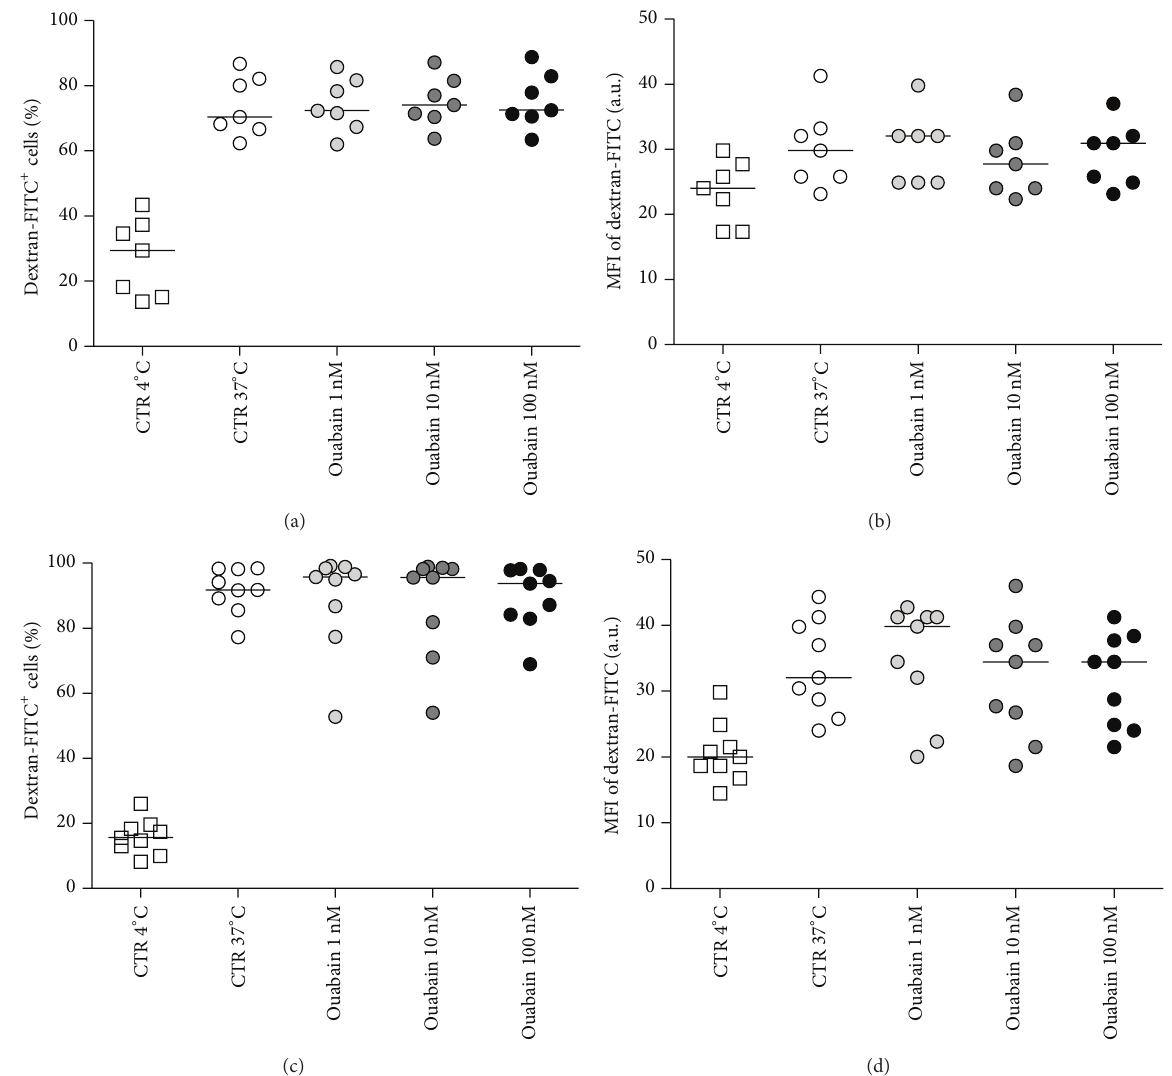
Figure 7: Effect of ouabain on in vitro dextran endocytosis by resident peritoneal leukocytes. ((a), (b)) Resident peritoneal cells were incubated with 1, 10, and 100nM ouabain and 0.5 mg/mL of FITC-conjugated dextran for 1 hour at 37 ∘ C or 4 ∘ C (control endocytic activity), and fluorescence signals were analyzed by flow cytometry. Scatter plots indicate the percentage of dextran-FITC + cells (a) and the median fluorescence intensity of dextran-FITC (b). ((c), (d)) Prior to the endocytic assay, resident peritoneal cells were cultured in the absence or presence of ouabain for 24 hours. After this culture period, these cells were then incubated for 1 hour with FITC-conjugated dextran at 37 ∘ C or 4 ∘ C, and fluorescence signals were analyzed by flow cytometry. Scatter plots indicate the percentage of dextran-FITC + cells (c) and the median fluorescence intensity of dextran-FITC (d). Lines refer to the median of the results obtained from at least 7 animals per group.